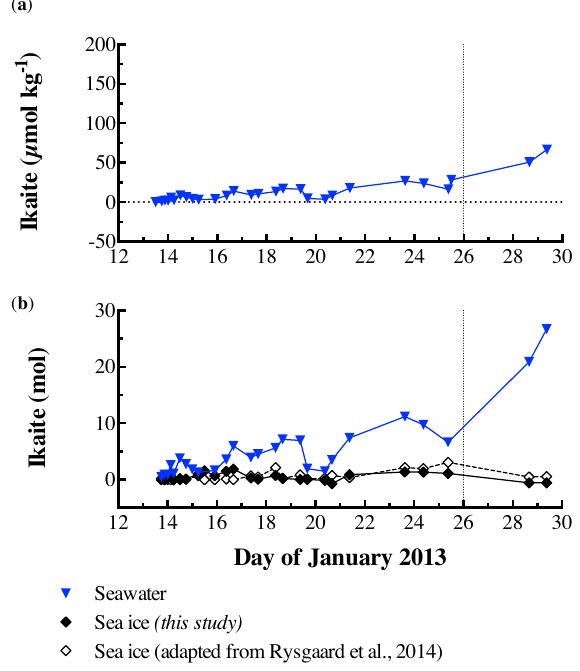
Figure 8. Evolution of (a) ikaite dissolution within the water col- umn (in µmolkg − 1 ), (b) mass of ikaite dissolved in the underlying seawater (blue) and mass of ikaite precipitated in sea ice (black) es- timated from this study and estimated from Rysgaard et al. (2014) (white). The vertical black dotted line on 26 January marks when the heat was turned back